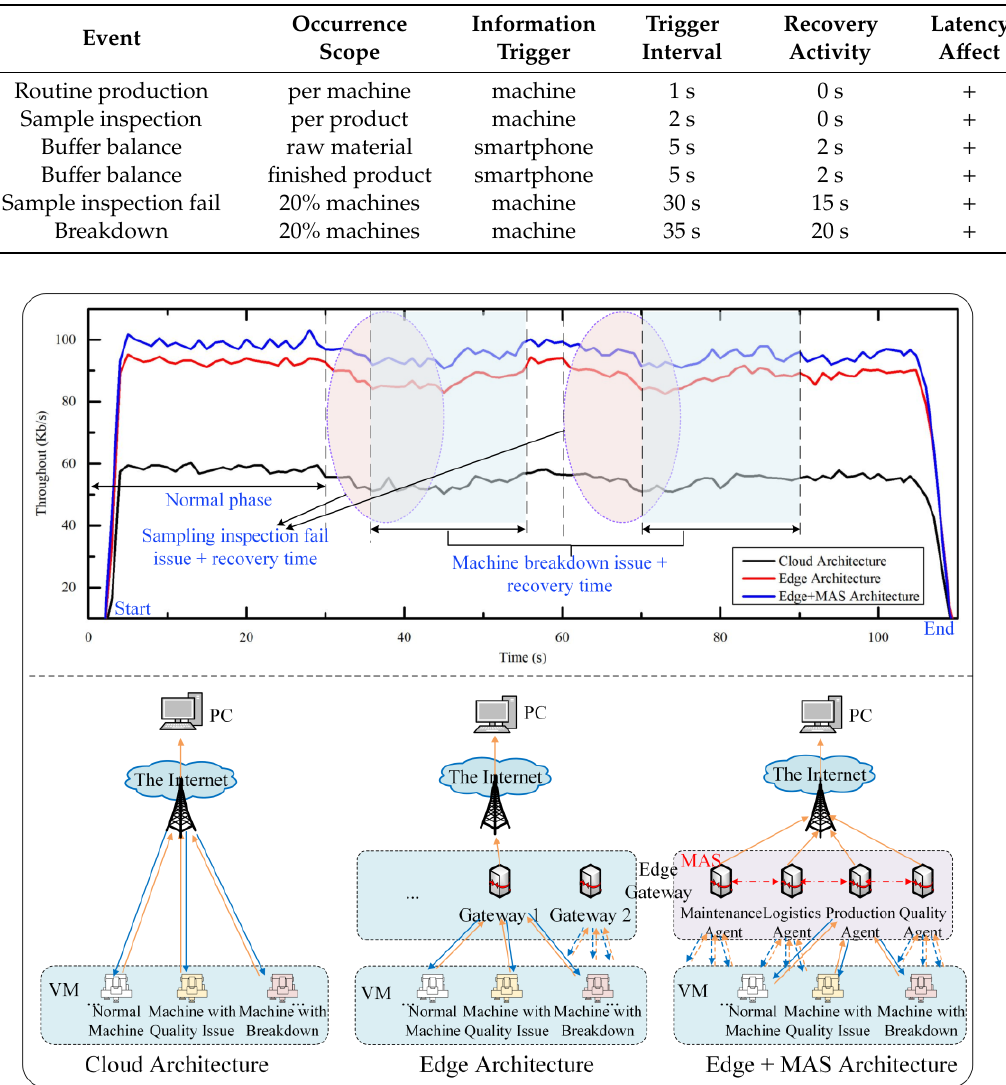
Figure 10. Simulation result of the virtual manufacturing environment (VME).